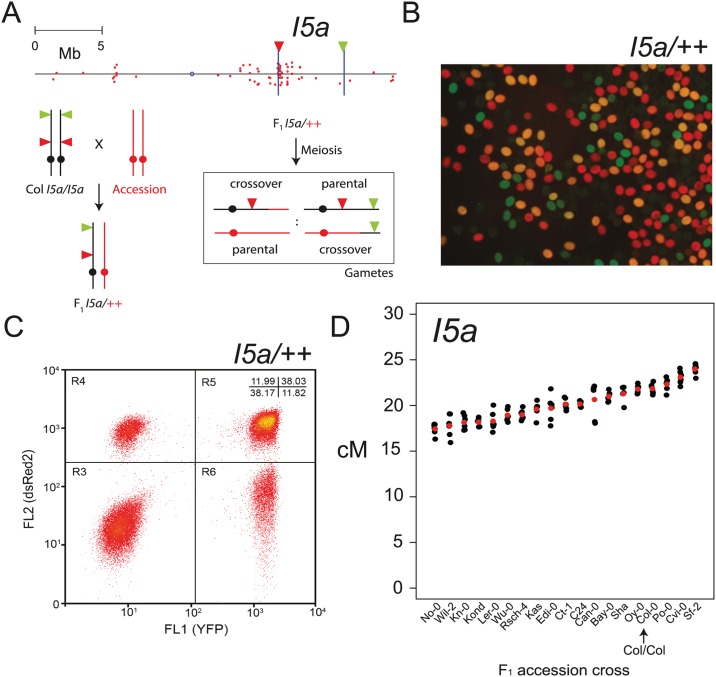
NBS-LRR cluster recombination rate is modified by natural genetic variation.(A) Physical map of chromosome 5 with NBS-LRR gene positions indicated by red dots. The positions of FTL T-DNAs that define I5a are indicated by vertical blue lines, with triangles indicating the colour (red or yellow) of fluorescent protein encoded. Beneath is a diagram illustrating the generation of FTL hemizygous F1 plants and scoring of crossover recombination in pollen. Crossover within I5a leads to pollen with red or yellow fluorescence alone, whereas the parental classes are either without fluorescence or show both red and yellow. (B) Fluorescence micrograph of pollen from I5a/++ hemizygotes, showing the presence of four fluorescent classes. (C) A representative flow cytometry plot of pollen from I5a/++ hemizygotes. Points represent individual pollen grains measured for yellow (FL1 YFP) and red (FL2 dsRed2) fluorescence. (D)
I5a genetic distance (cM) measured from individual F1 plants (S18 Table). Mean values are shown in red. The accession crossed to is indicated on the x-axis. The Col/Col homozygous sample is labelled and indicated with an arrow.